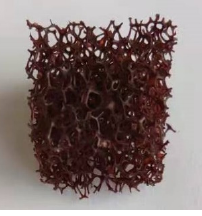
Figure 5. Photograph of the spent EY-APTES@PDA@PUF foam after six cycles of 2-methyl-5-nitro- isoquinolin-2-ium iodide oxidation.